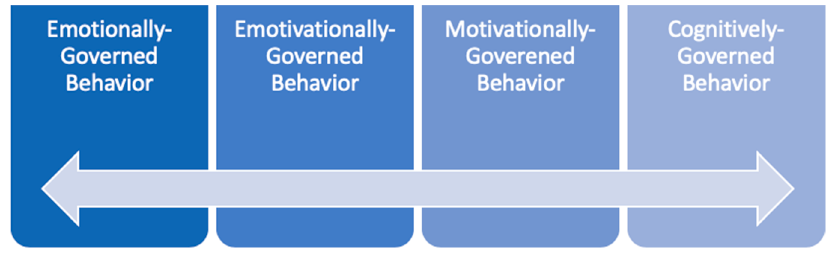
Figure 5. Emotion-Behavior Gradient Scale.